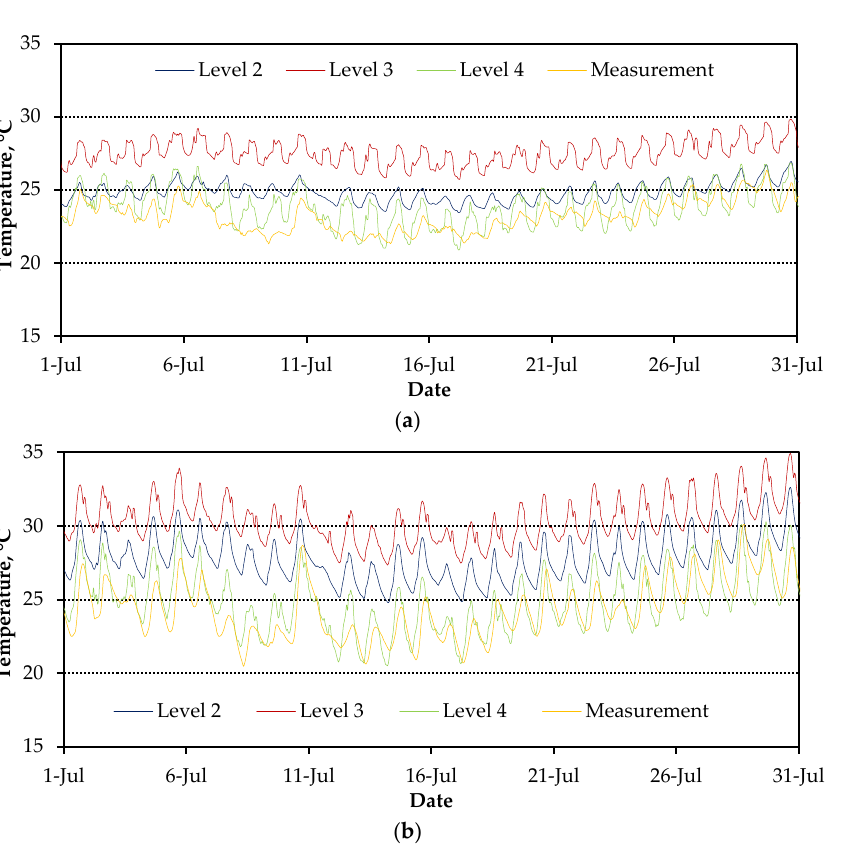
Figure 9. Measured and calculated indoor air temperature (average hourly values) in July ( a ) in the living room; ( b ) in room 1.